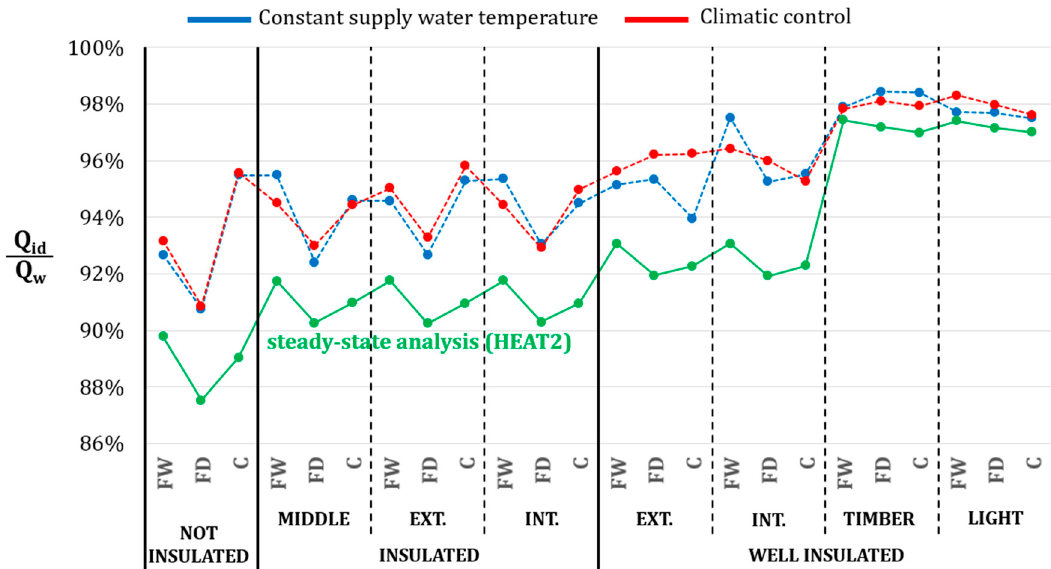
Figure 6. Efficiency of the radiant systems limited to the period from December to February, obtained considering the same operative temperature of the ideal convective simulations and (in green) efficiency calculated by FDM in steady-state conditions.